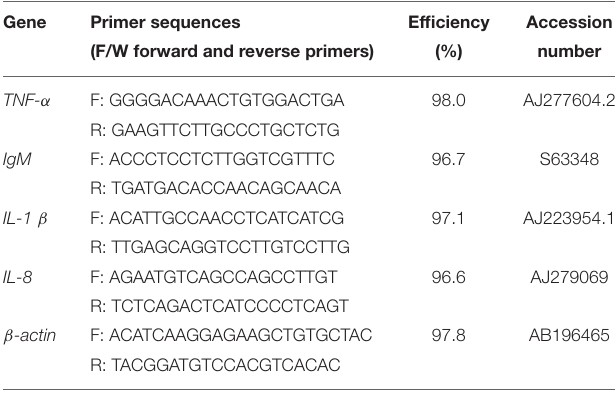
Gene Primer sequences